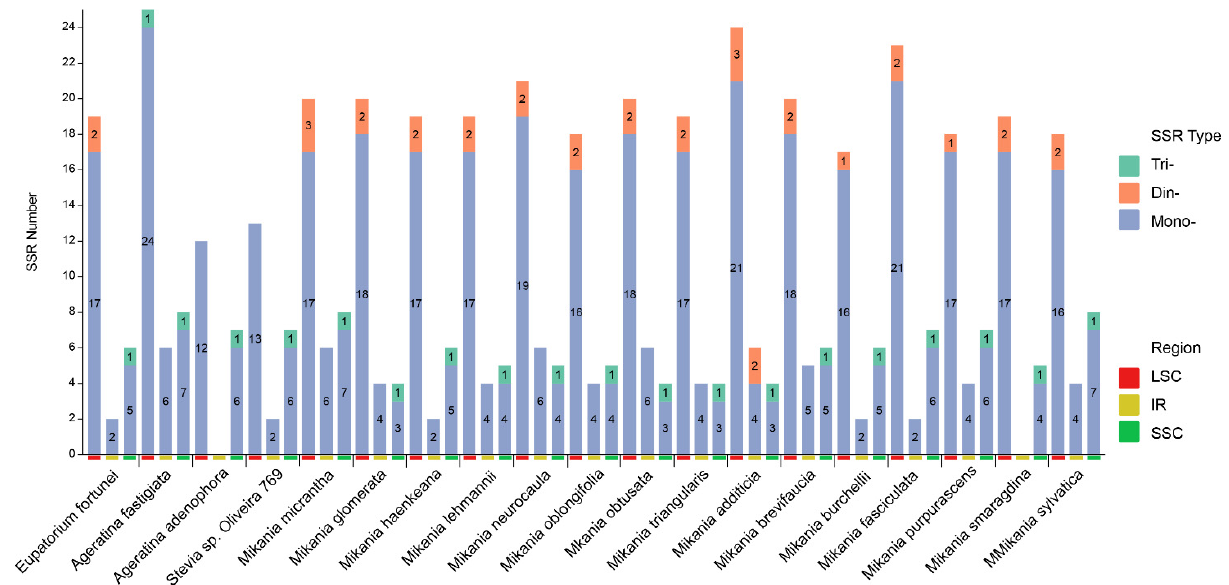
Figure 3. Distribution of SSRs in various regions of 19 Eupatorieae species. The x -axis represents the 20 Eupatorieae species and the position of each SSR in the chloroplast genome. The y -axis represents the number of SSRs in each chloroplast genome. Mono-, mononucleotide repeat; Di-, dinucleotide repeat; Tri-, trinucleotide repeat; Tetra-, tetranucleotide repeat.